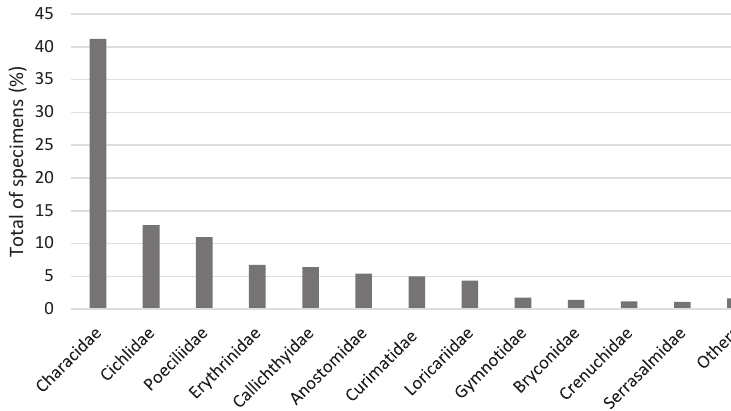
Figure 4. Percentages of the total number of specimens in each lowish; black horizontally elongated blotch on caudal peduncle, extending to median caudal-fin rays. Figure 5D Geographic distribution. Upper Paraná and São Fran‑ cisco river basins, Brazil. Materials examined. Vouchered materials: LIRP 15717; Sampling site M of Table 1.